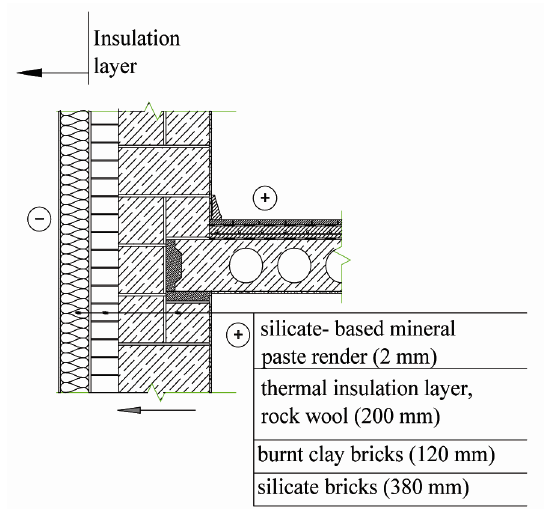
Fig. 4. Improvement of the thermal insulation layer (200 mm in width) on walls of the building. Thermal bridge is eliminated along the wall and slab